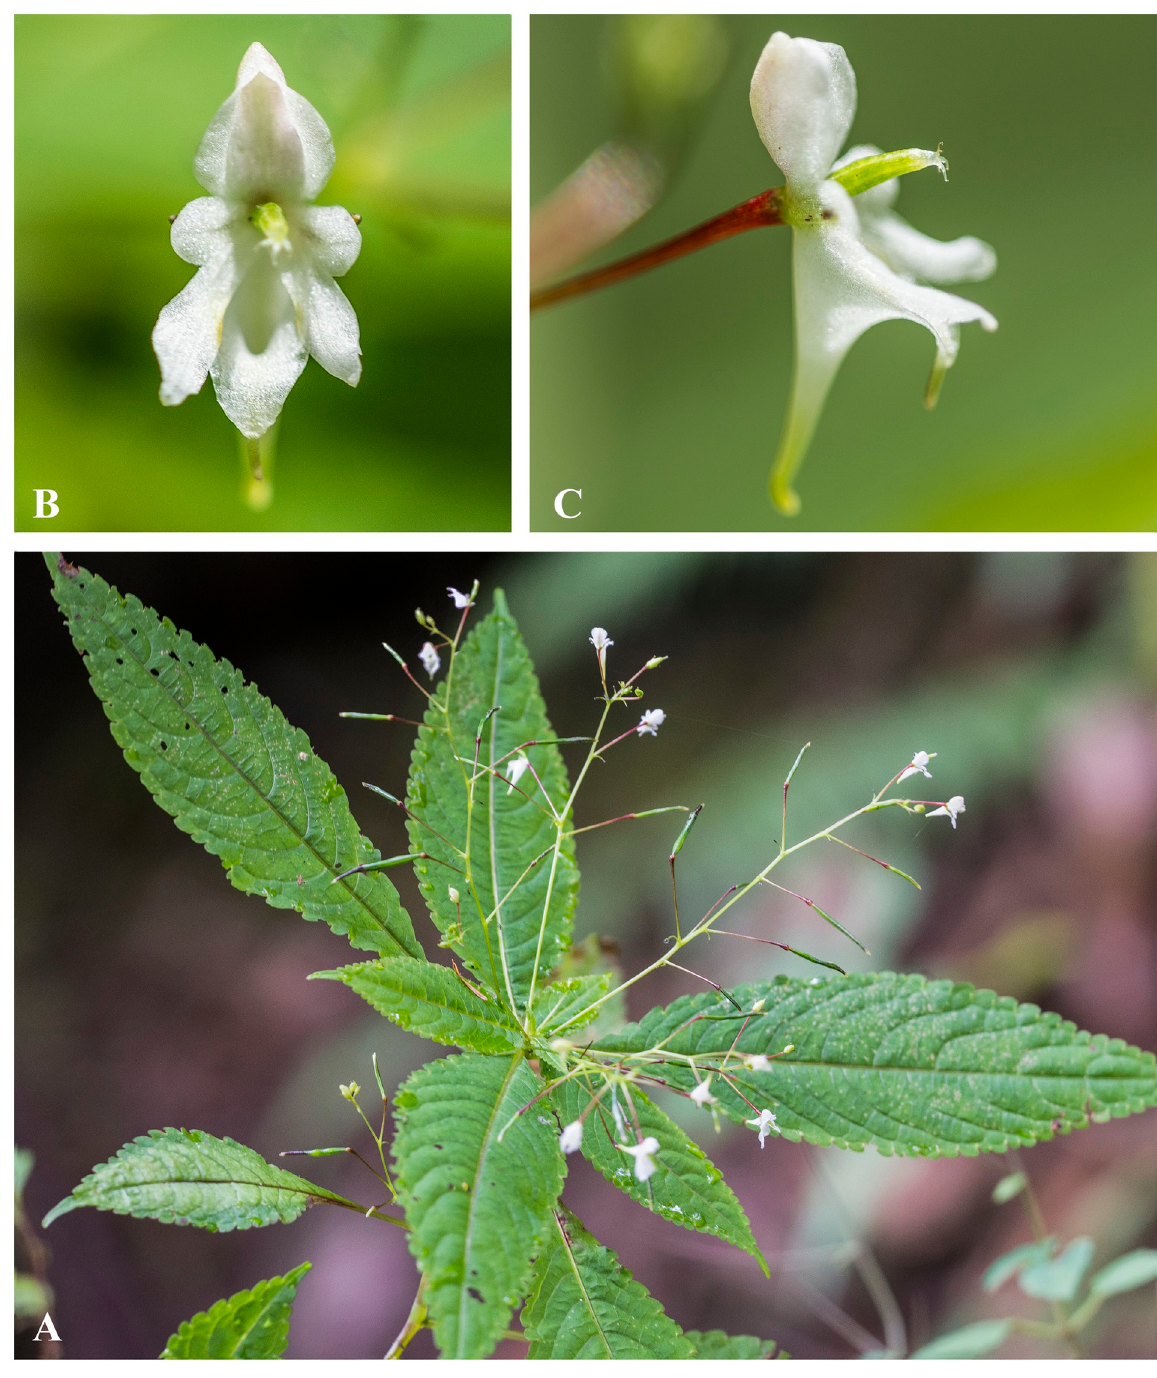
Fig 22. Impatiens radiata A. Flowering plant; B. Flower (Front view); C. Flower (side view). Photographs by Bhakta Bahadur